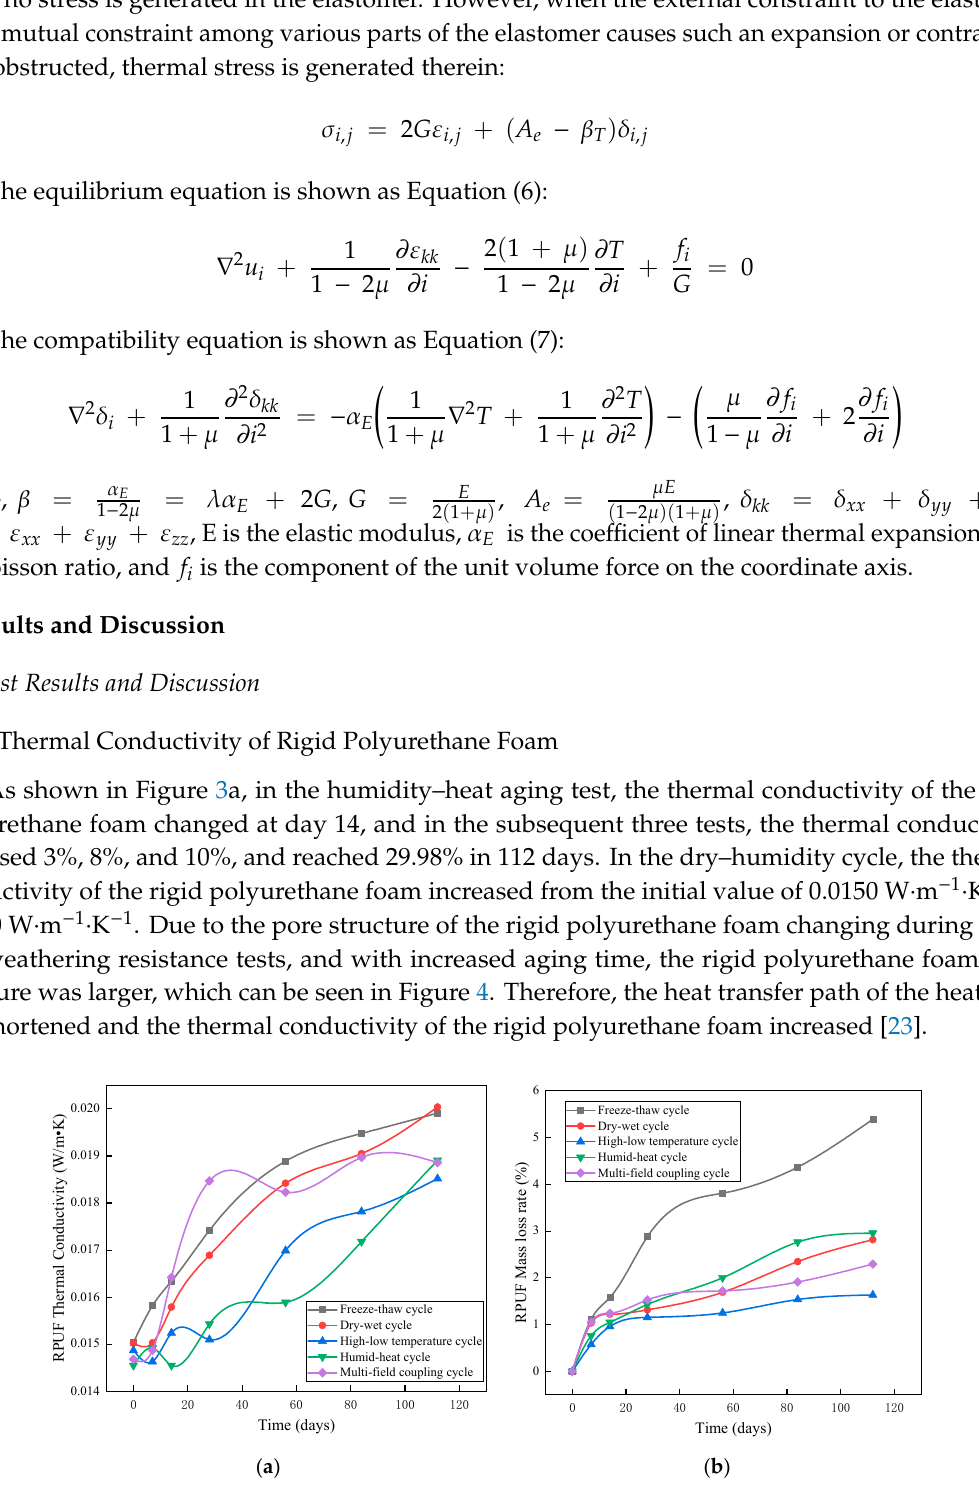
Figure 3. Changes in the rigid polyurethane foam (RPUF) in weathering resistance tests: ( a ) change in thermal conductivity of the rigid polyurethane foam, and ( b ) change in mass loss of rigid polyurethane foam.